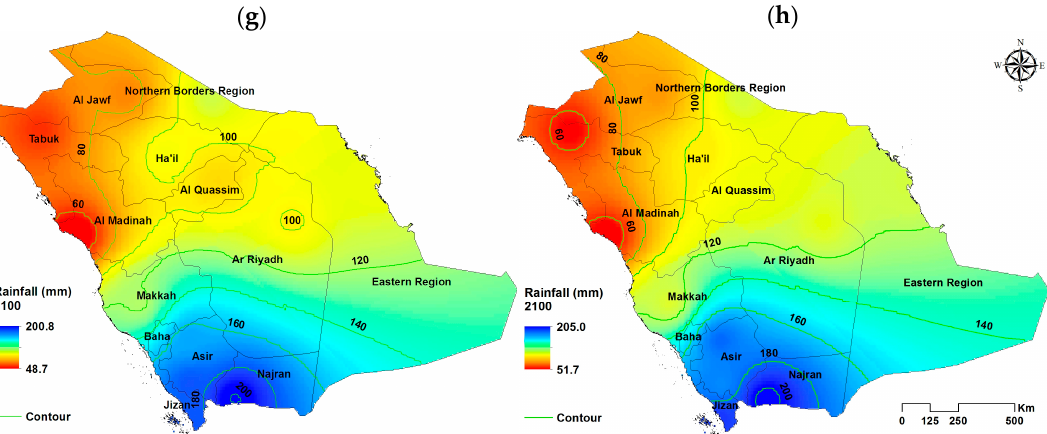
Figure 5. Annual-averaged rainfall (mm) SSP2-4.5 on the left for ( a ) 2040, ( c ) 2060, ( e ) 2080, and ( g ) 2100 and SSP2-8.5 on the right for ( b ) 2040, ( d ) 2060, ( f ) 2080, and ( h ) 2100.3.3. Reference Evapotranspiration Distribution and Change.